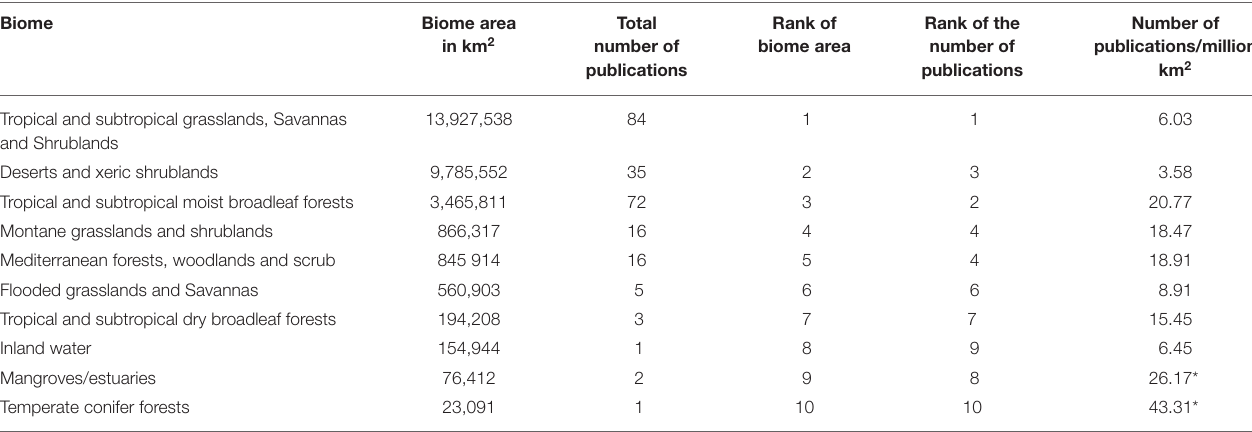
TABLE 1 | Distribution of road ecology publications in the 10 biomes within